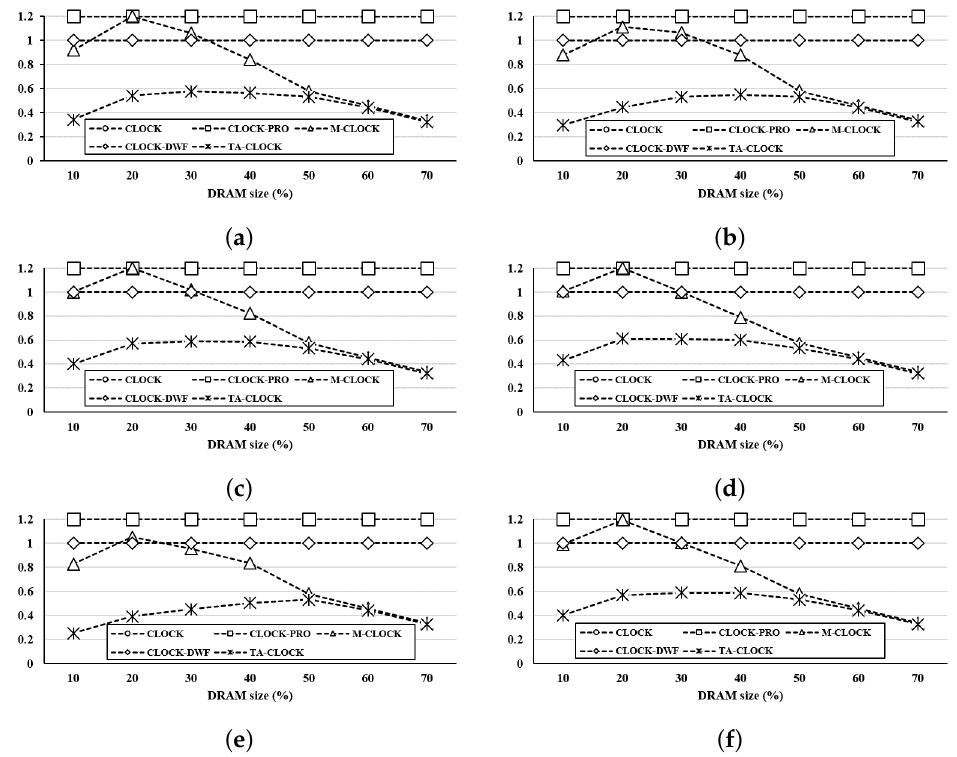
Figure 6. Normalized write operations in the PCM (values of 1.2 or higher are indicated as 1.2).